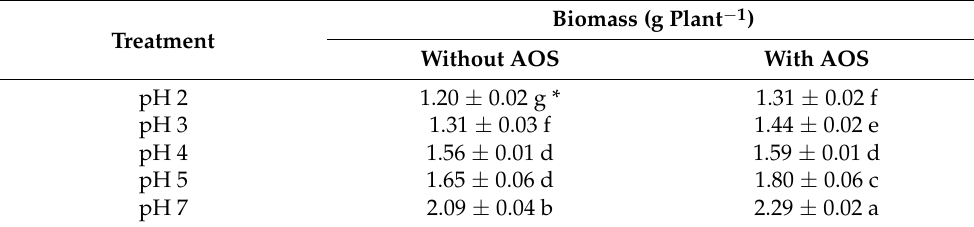
Table 1. Effect of alginate oligosaccharides (AOS) fertilizer on plant biomass for 7-day high temperature-low pH compound stress on leaf.